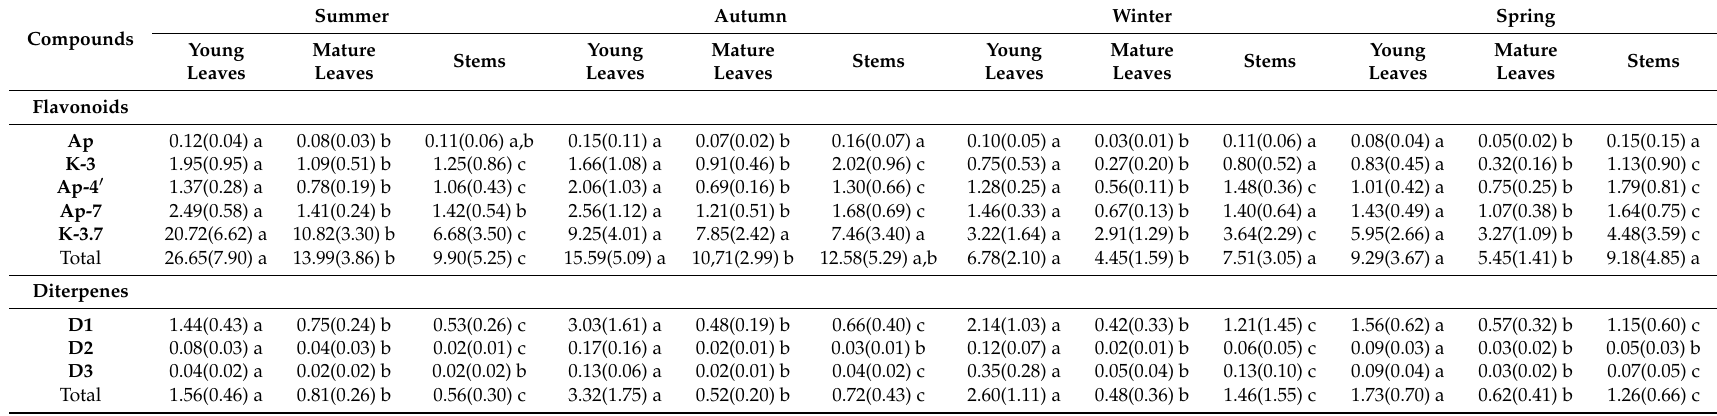
Table 1. Total flavonoids and diterpenes (standard deviation) of the exudate of 20 individuals of C. ladanifer in the different tissues analysed, by season (mg/g dw). Mean of two